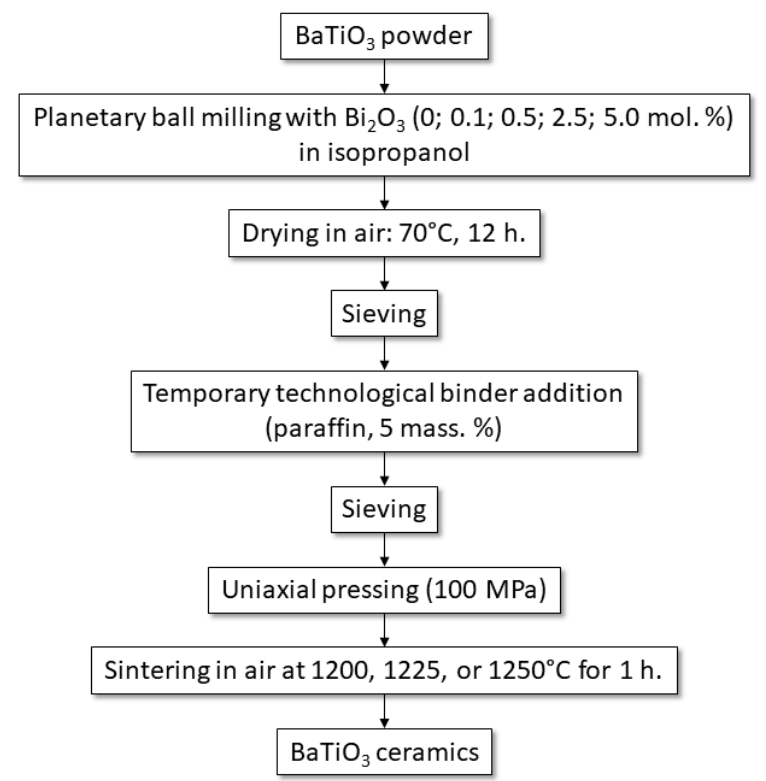
Figure 10. BaTiO 3 ceramic processing scheme.